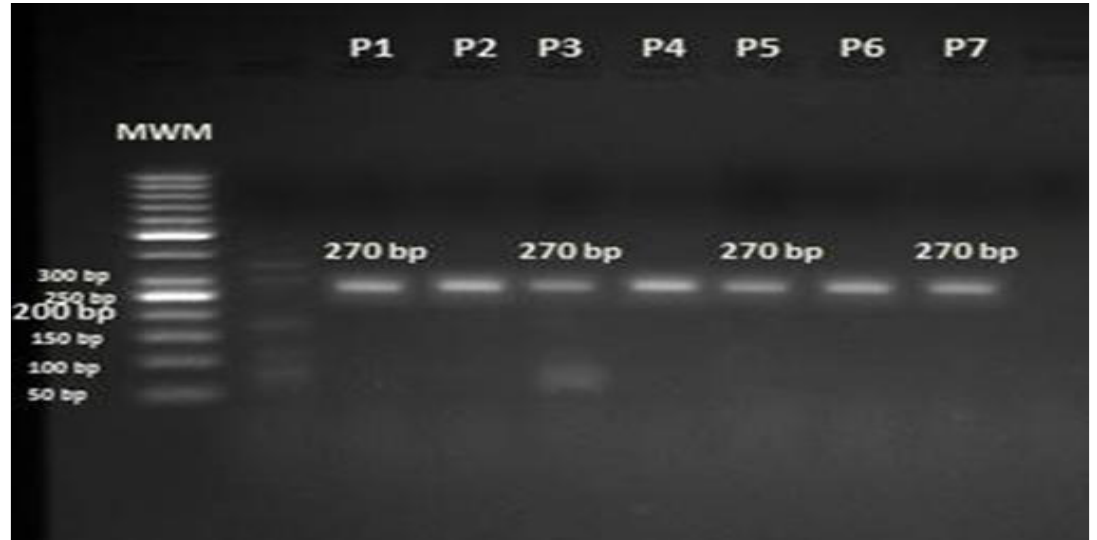
Figure 2. Agarose gel electrophoresis of PCR products after amplification of toxA gene. MWM; molecular weight marker (50 bp DNA ladder, DL004, Biomatik), p1, p2, p3, p4, p5, p6 and p7; P. aeruginosa positive for toxA gene (MW; 270 bp).